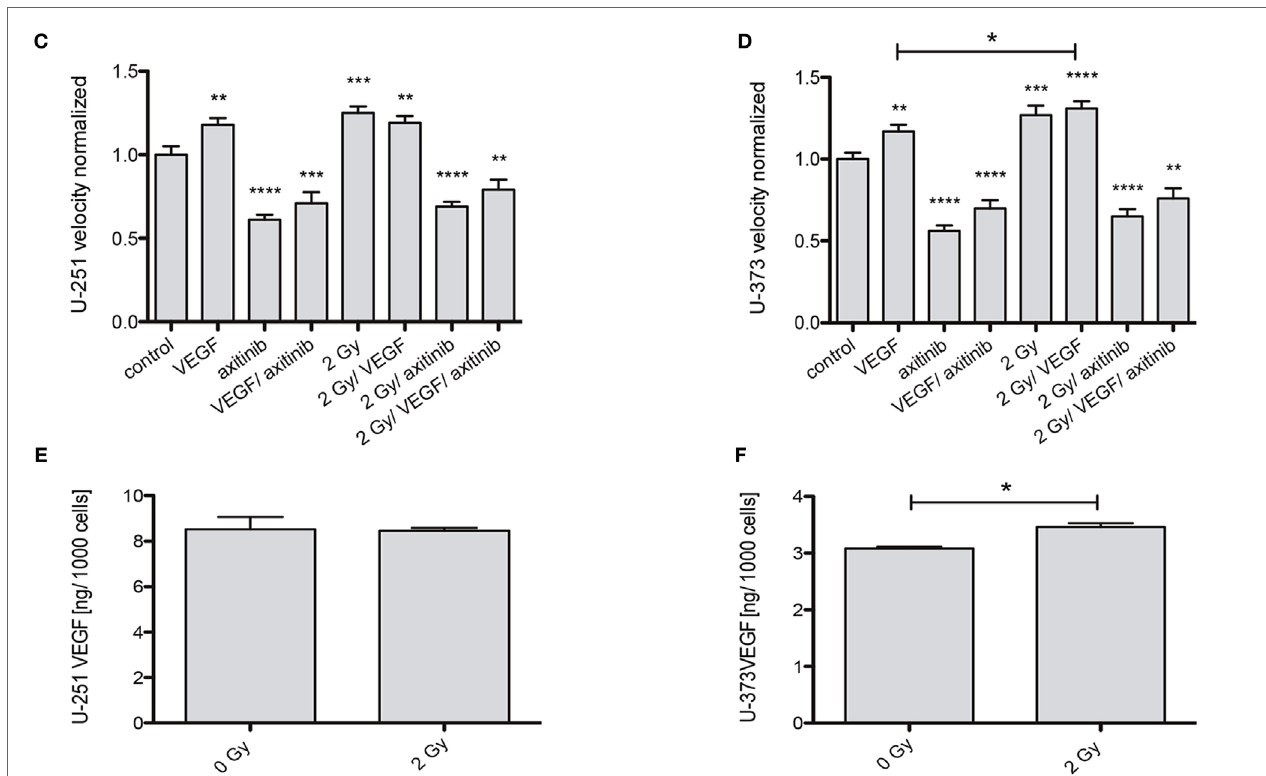
FigUre 2 | Influence of vascular endothelial growth factor (VEGF), axitinib, or irradiation with 2 Gy photons on the motility of glioblastoma multiforme cell lines U-251 and U-373. The motility of the cells was analyzed by time-laps videography. Cells were tracked and analyzed with the ibidi chemotaxis and migration tool. (a) Examples from an image stack of Videography. Some cells migrate fast (2), some slowly (3), some even do not migrate (1). Dividing cells (4) often keep contact over longer periods of time (4a, 4b). Scale bars: 50 µm. (B) Migration of U-373 glioblastoma cells under varied conditions. Depicted are the tracked cells in representative fields of view. The software merges all starting points in the origin to get an explicit view of the paths migrated by the cells. It is clearly visible that the migration is undirected (an advantage of videography over other methods to analyze migration). It is notable that some irradiated cells are able to escape the inhibition by axitinib. (c,D) The motility of U-251 and U-373 cells is increased by VEGF as well as by irradiation. In U-373, a combination of both leads to a significant increase in velocity compared to VEGF alone (D) , in U-251 no additive effects could be observed. In contrast, axitinib diminishes the motility of untreated cells and the elevated motility after irradiation as well. VEGF and axitinib were added in concentrations of 0.1 and 10 µg/ml, respectively. (e,F) 24 h after 2 Gy irradiation the amount of VEGF in the supernatant of U-251 and U-373 was analyzed. In U-251 there were no significant changes detectable, whereas in U-373 cells VEGF was significantly increased (F) . Data are shown as mean ± SEM. Data were tested for significance using one-way ANOVA with Bonferroni multiple comparison post-test. Significant differences are indicated by * p < 0.05; ** p < 0.01; *** p < 0.001; **** p <